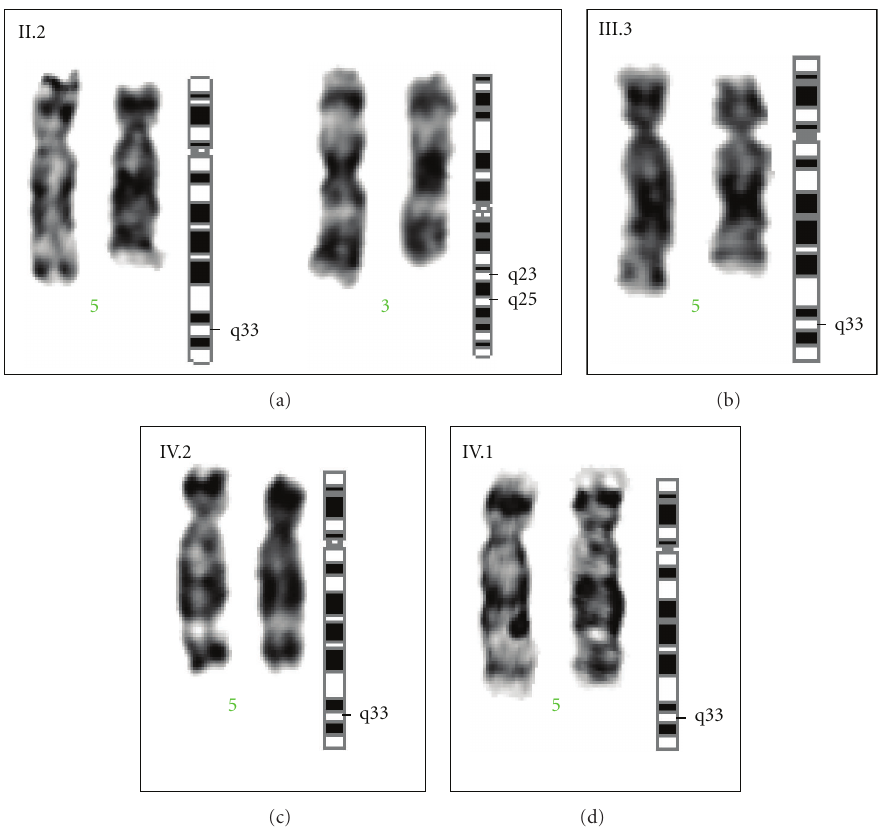
Figure 3: (a) G-banded image of chromosome 3 and 5 showing del(5)(q32-33)del(3q)(q23–25) in II.2. (b) G-banded image of chromosome 5 showing del(5)(q32-33) III.3. (c) G-banded image of chromosome 5 showing del(5)(q32-33) IV.2. (d) G-banded image of chromosome 5 showing del(5)(q32-33) in